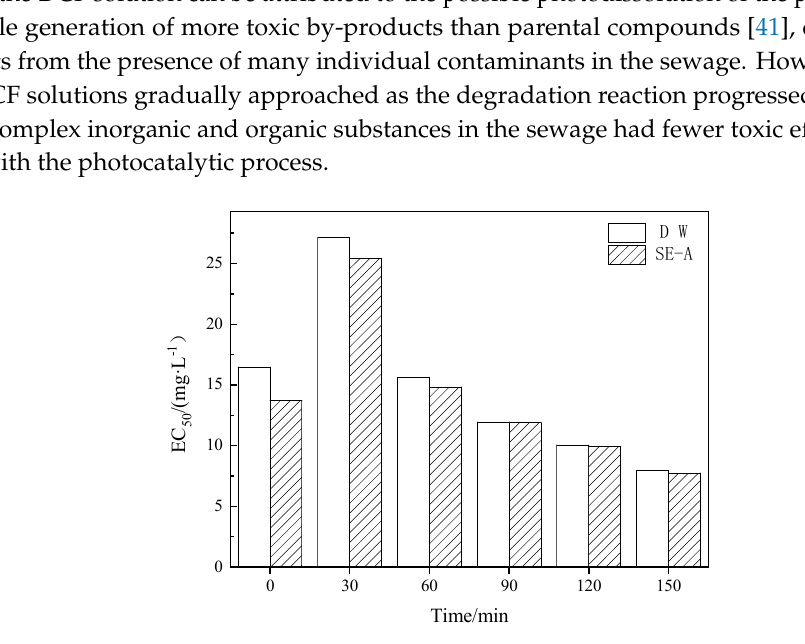
Figure 5. The toxicity of DCF solution under di ff erent background water.